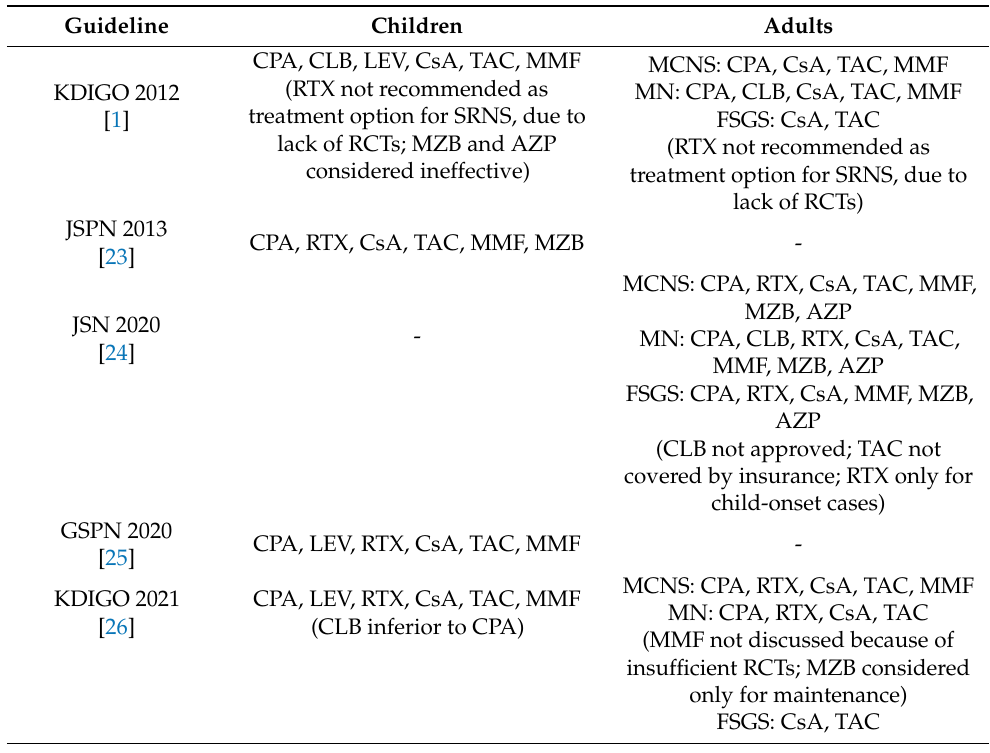
Table 1. List of immunosuppressive agents other than corticosteroid (CS) in recent guidelines for nephrotic syndrome (NS) in children and adults. Guideline Children Adults KDIGO